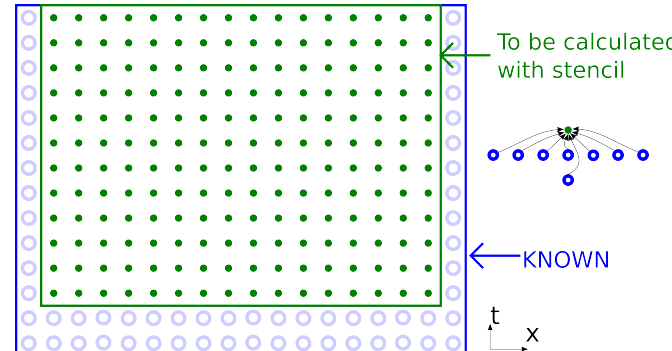
Figure 2. Dependency graph of the problem (arrows are omitted) with example stencil for sixth order of